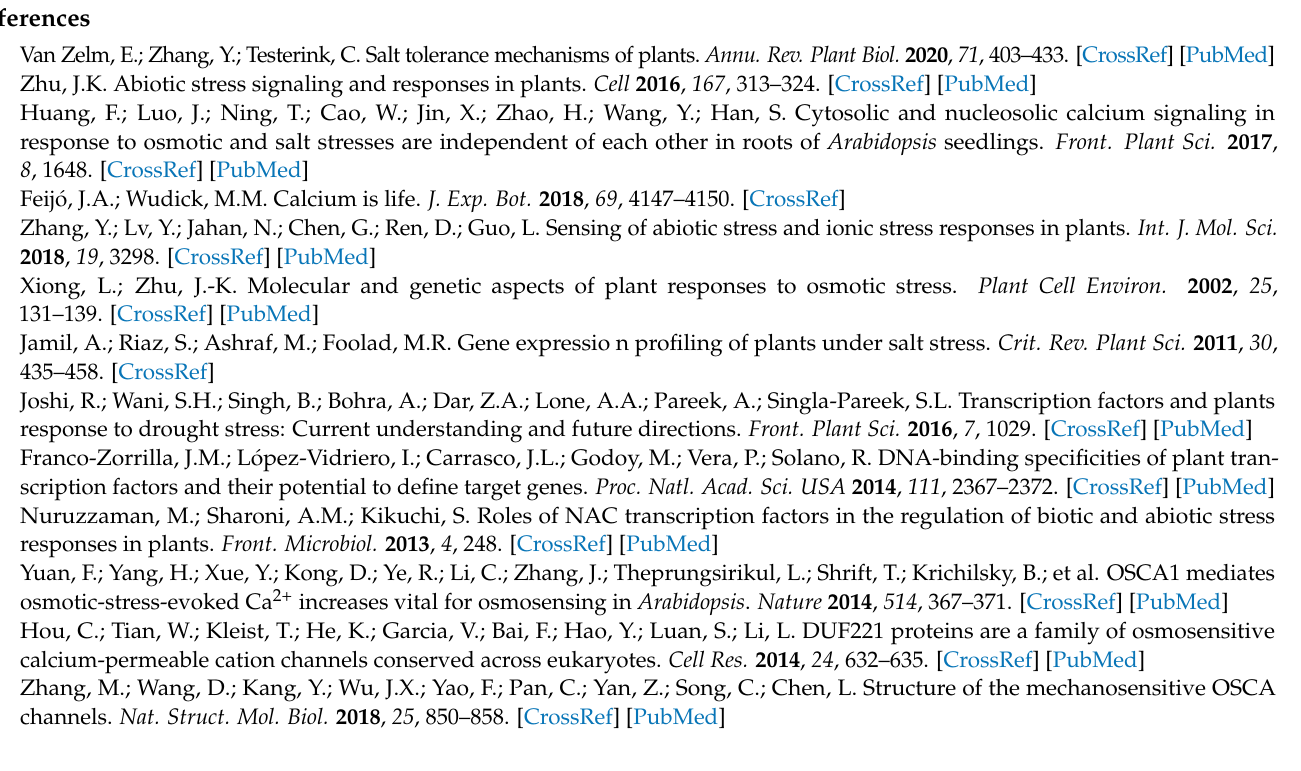
Figure S5. The enrichment analysis of the “molecular function” category of GO, with OsOSCA1.1- regulated genes in 30-day-old rice shoots in response to hyperosmolality and salt stress treatment. (A) Sorbitol response genes. (B) Osmotic stress response genes. (C) NaCl response genes. GO term information for DEGs was extracted from BLAST results against the SWISS-PROT database and the top 10 terms are